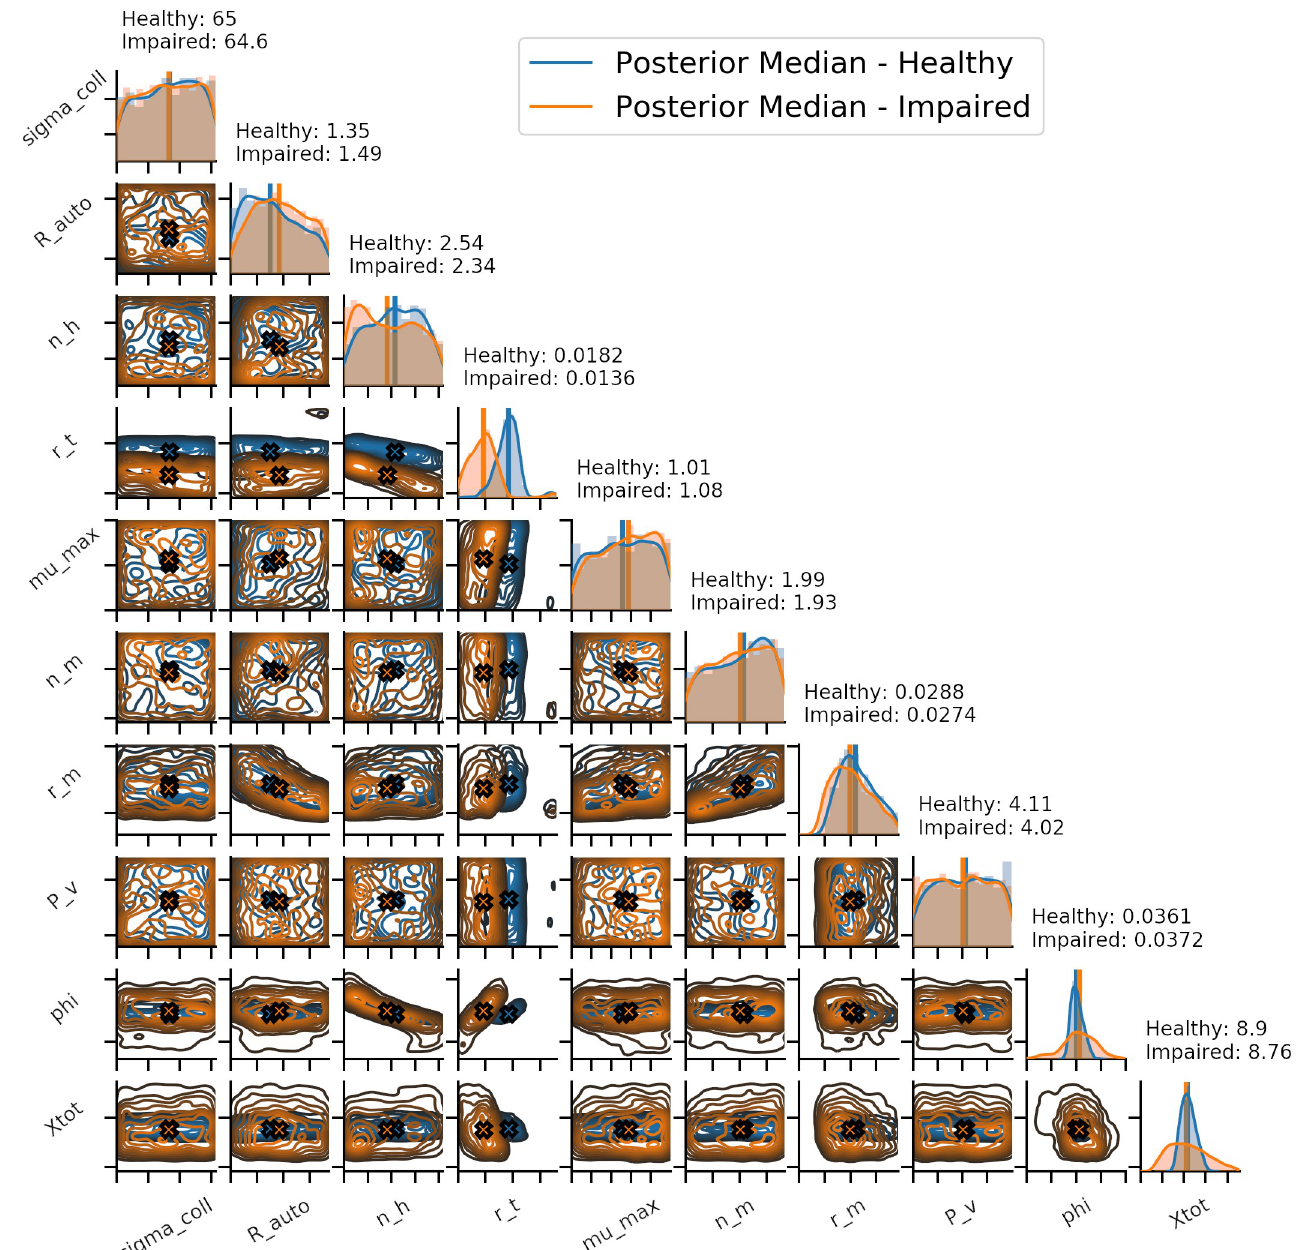
Fig 9. Comparison of posterior distributions for healthy and impaired simulated data. Fig 9 shows the posteriors for healthy and impaired data based on an acceptance rate of 0.01%. Posterior are shown over the full prior range as defined in S1 and S2